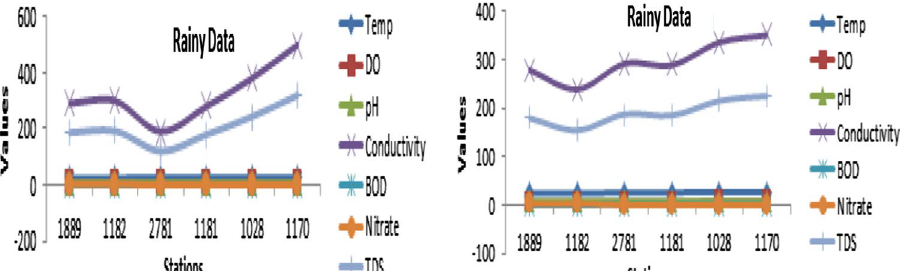
Fig. 8 Year-wise data of TDS at each station for rainy season